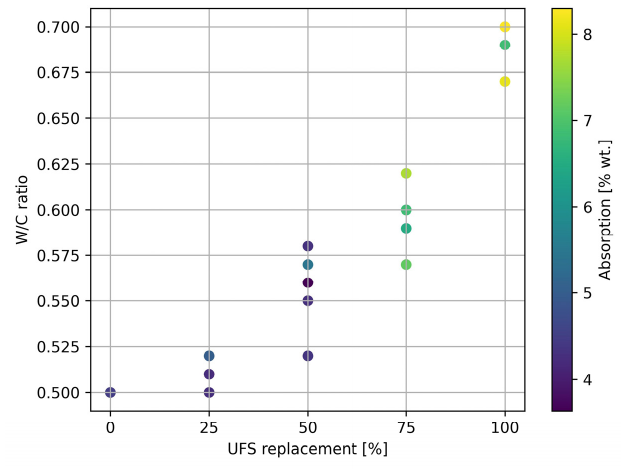
Figure 13. Absorption coefficient of mortars with UFS (% wt.).